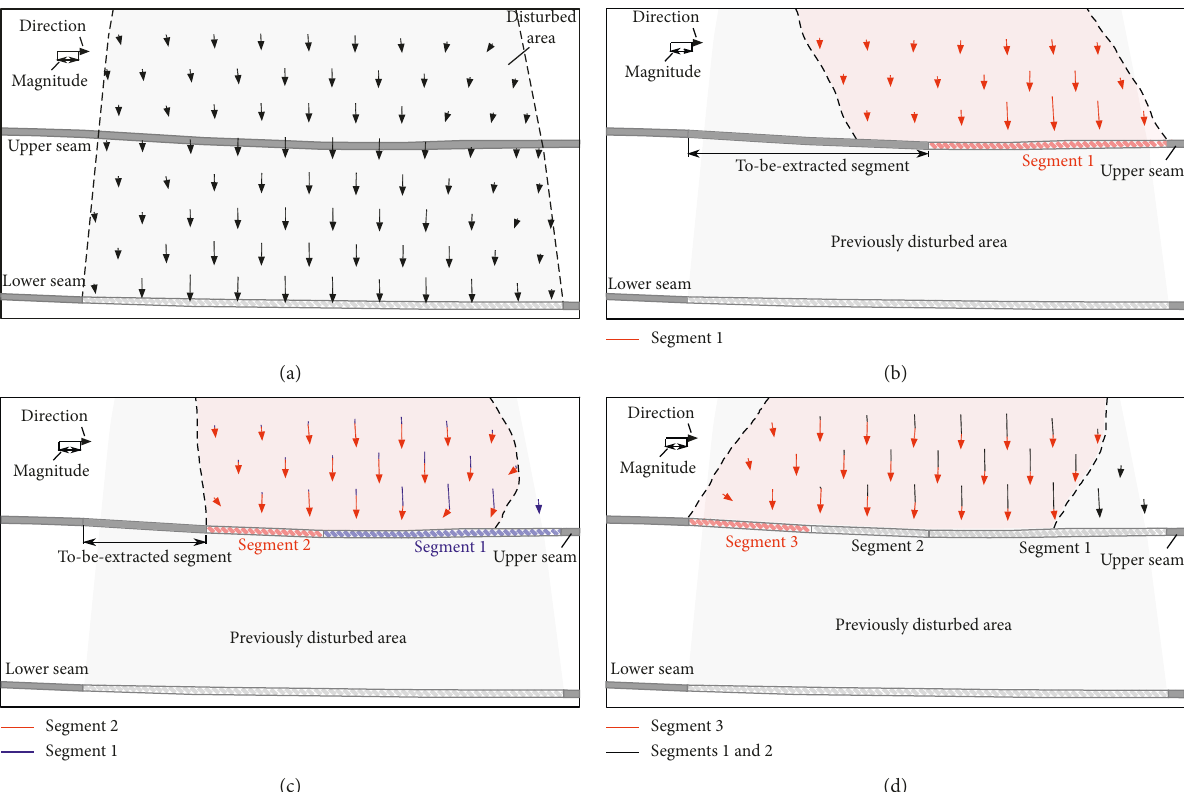
Figure 7: Deformation pattern after extraction of (a) lower panel and (b–d) different segments of the upper panel in Case 2.